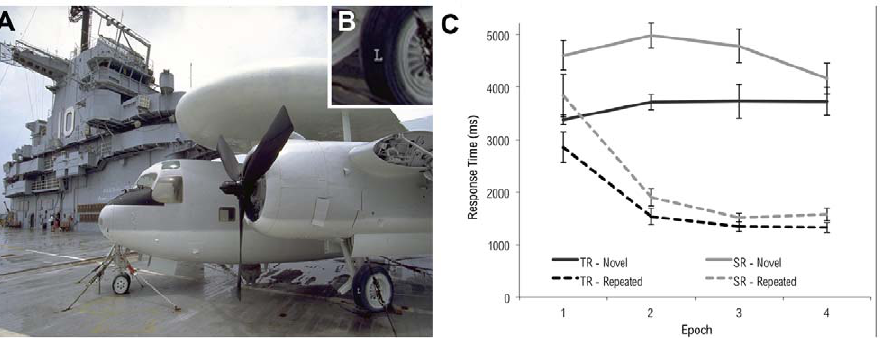
Figure 4. Example of stimulus used in Experiment 2. (A) Participants search for and identify a T or L target letter (here, a letter ‘‘L’’ on the aircraft tire, lower right). (B) Inset detail reveals target location. (C) Results of Experiment 2. Both typical readers and individuals with dyslexia show progressively faster search times for repeated trials, but not for novel trials. The magnitude of this difference was equivalent for both groups.